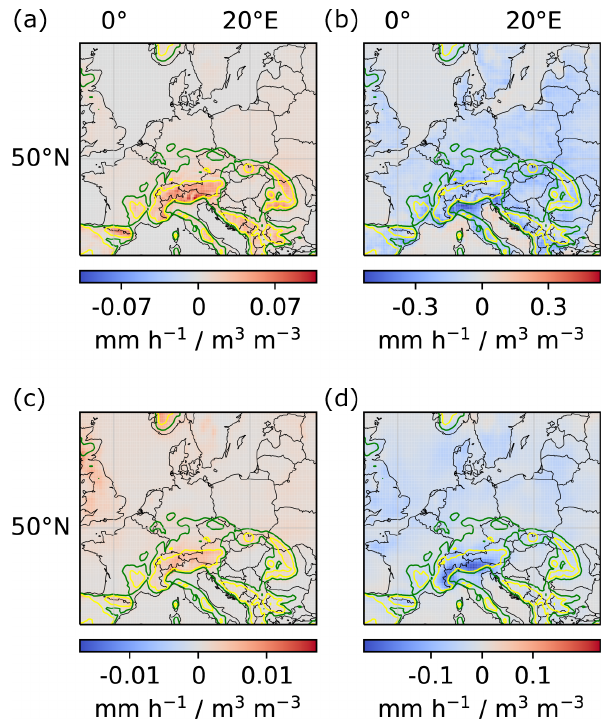
Figure A6. Local and regional soil-moisture–convective- precipitation and soil-moisture–large-scale-precipitation cou- plings. (a, c) Local couplings. (b, d) Regional couplings. (a, b) Soil-moisture–convective-precipitation coupling. (c, d) Soil- moisture–large-scale-precipitation coupling.